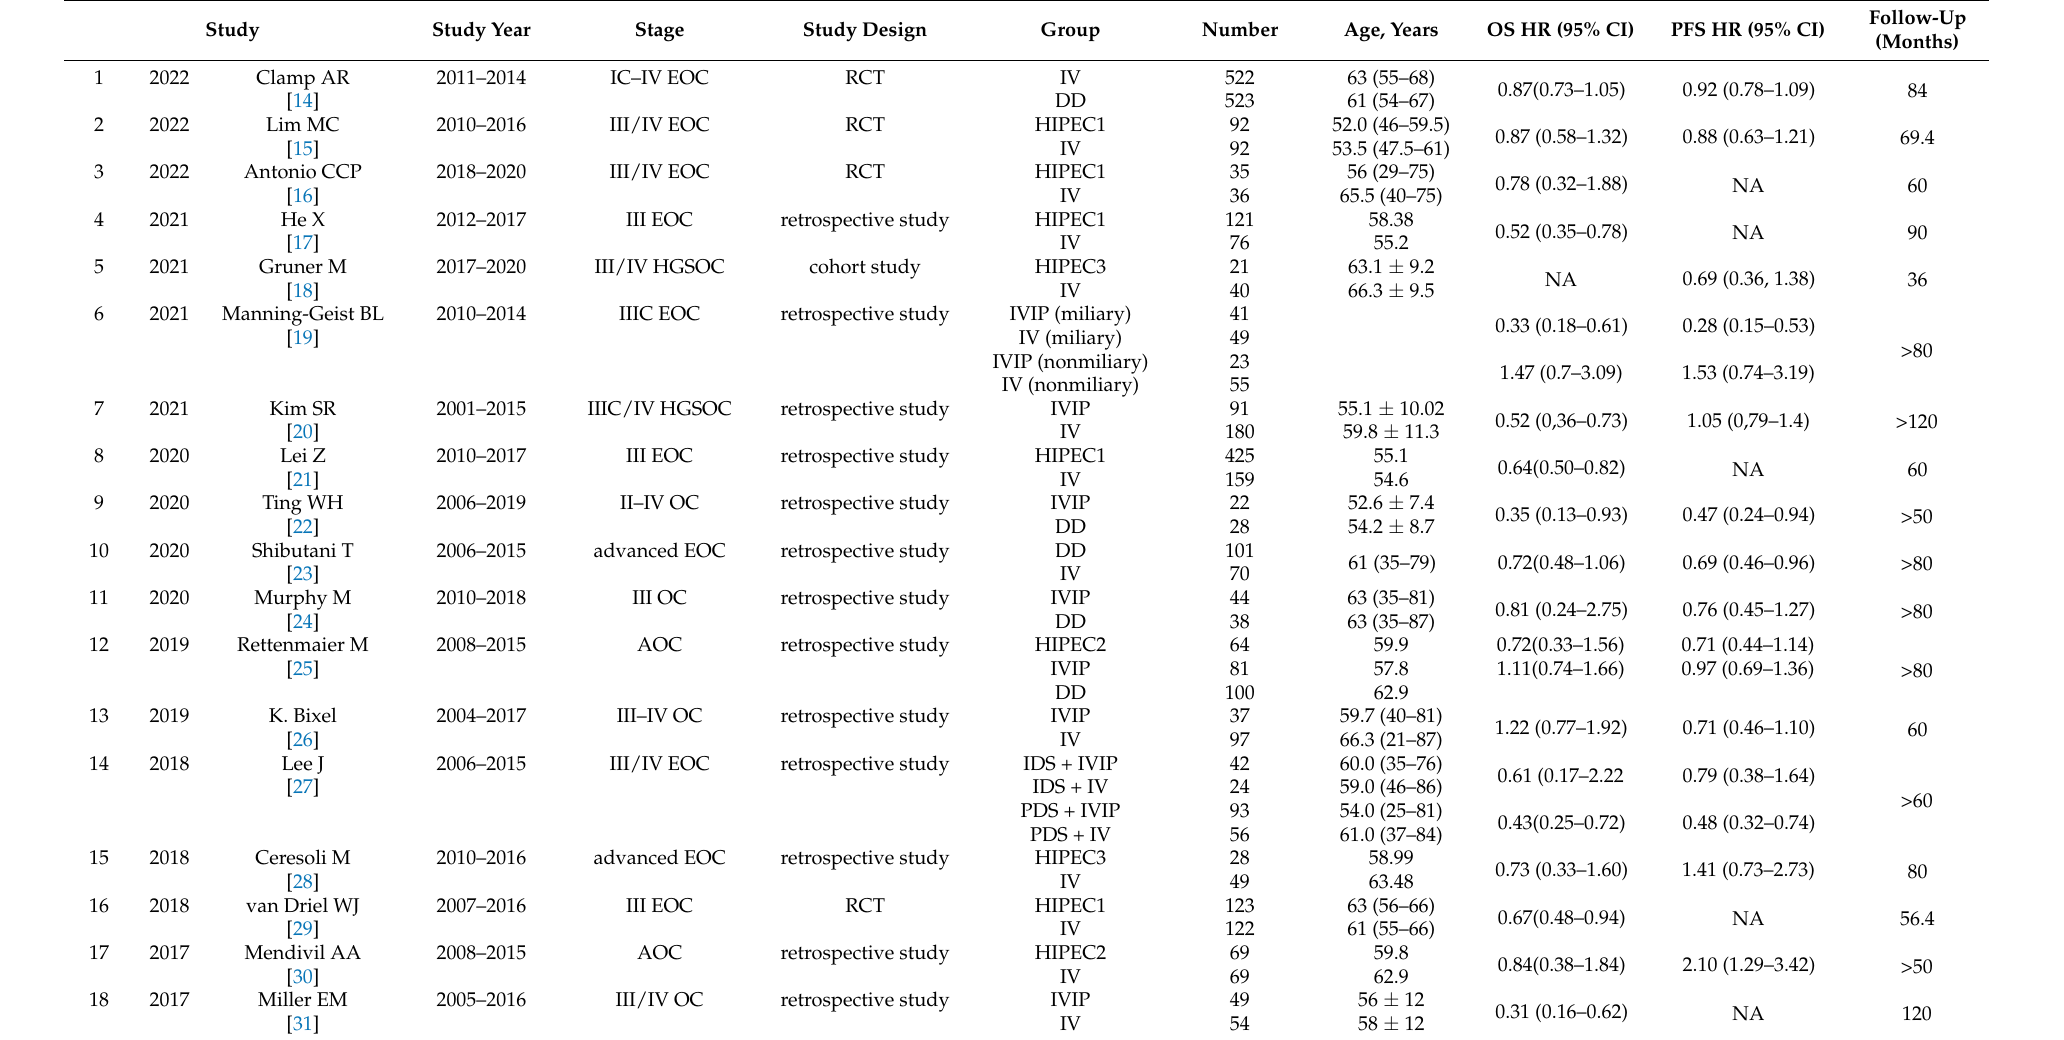
Table 1. Characteristics of included